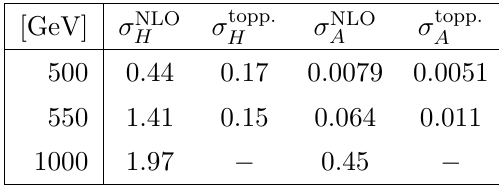
Table 3 . e + e (cid:0) ht (cid:22) t cross sections at NLO and for the topponium formation, whose sum gives ! the total cross section after Coulomb resummation in table 1. h = H for the SM Higgs, h = A for the CP-odd Higgs with ( (cid:20) htt ; (cid:24) htt ; (cid:20) hZZ ) = (1 ; (cid:25)= 2 ; 0). (cid:6) p s